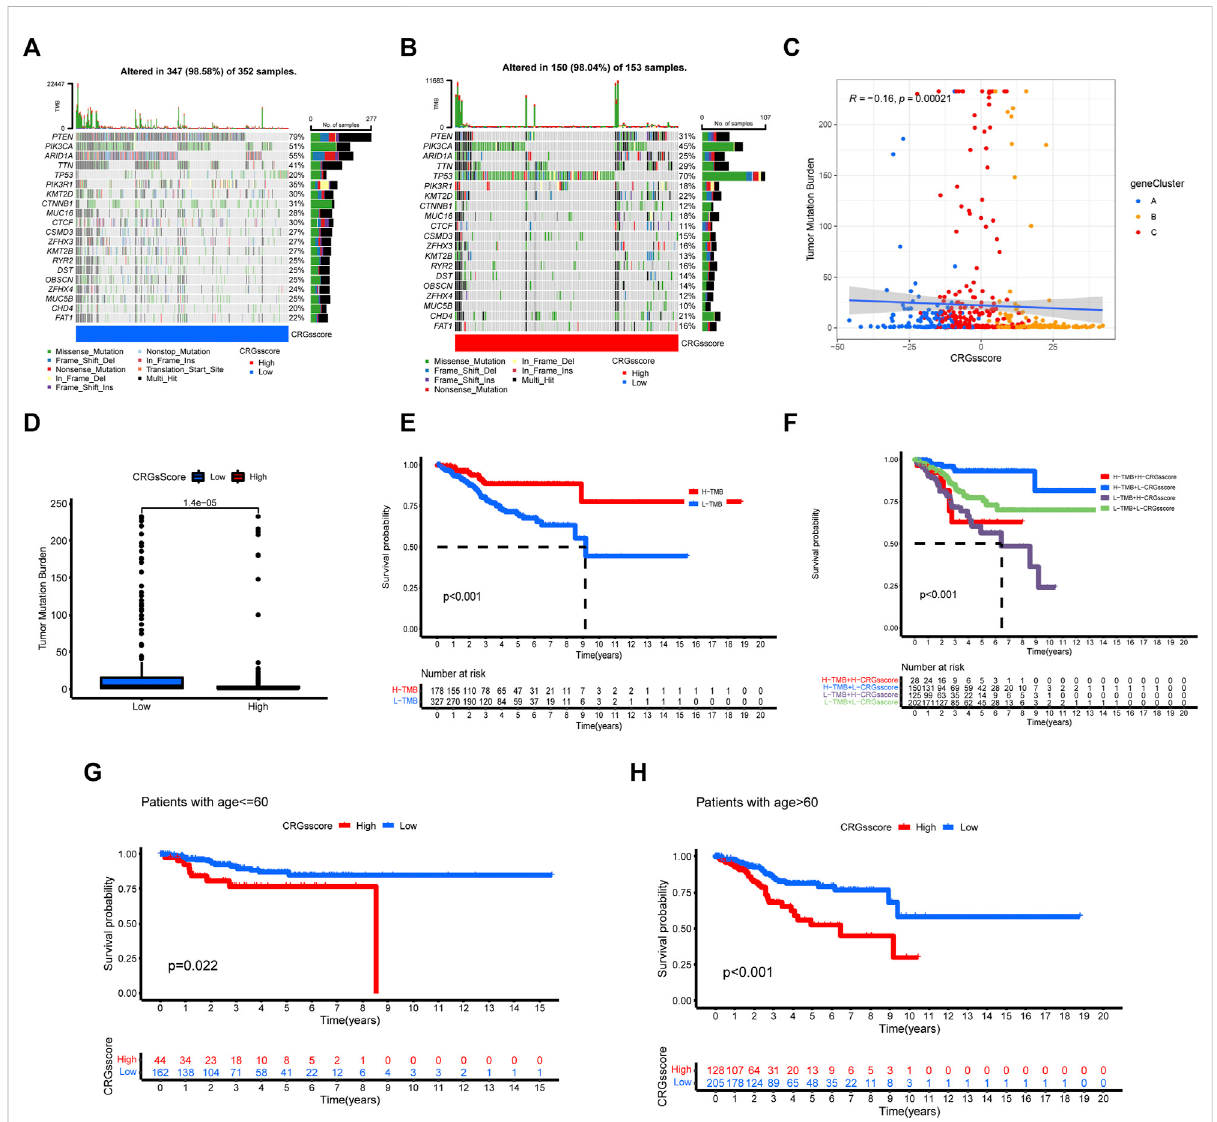
FIGURE 7 The relationship between CRGs score groups and somatic mutation, TMB. The waterfall plot of tumor somatic mutation in low CRGs score (A) and high CRGs score (B) . (C,D) The correlation between the CRGs score and TMB. (E) Survival analysis of CRGs score using Kaplan-Meier curves. (F) Survival analysis of both TMB and CRGs score using Kaplan-Meier curves. (G,H) Survival analysis of CRGs score in patients with age ≤ 60 and > 60 using Kaplan-Meier